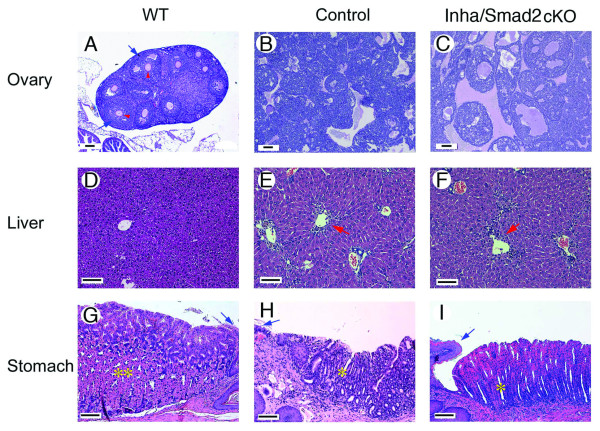
Histological analyses of ovary, liver, and stomach from WT, control, and experimental female mice. (A) Ovarian histology of an 8 wk old WT mouse. The ovary contains follicles at various developmental stages. Arrows indicate granulosa cells and arrowheads denote oocytes surrounded by a magenta-colored zona pellucida. (B and C) Ovarian histology of a 26 wk old Smad2flox/-; Inha-/- mouse (B) and a 23 wk old Smad2flox/-; Inha-/-; Amhr2cre/+mouse (C), respectively. Tumors from both genotypes were bilateral, large, hemorrhagic, and histologically indistinguishable. (D-F) Histology of livers from a 12 wk old WT mouse (D), a 15 wk old Smad2flox/-; Inha-/- mouse (E), and an 8 wk old Smad2flox/-; Inha-/-; Amhr2cre/+mouse (F). Hepatocellular death around the central vein and lymphocyte infiltration are present in the livers of both the Smad2flox/-; Inha-/- control and Smad2flox/-; Inha-/-; Amhr2cre/+mice (arrows). (G-I) Glandular stomachs from a 12 wk old WT mouse (G), a 26 wk old Smad2flox/-; Inha-/- mouse (H), and a 14 wk old Smad2flox/-; Inha-/-; Amhr2cre/+mouse (I). Note the depletion of parietal cells in both the control and experimental mice (single asterisk) in comparison with the WT mouse (the large and eosinophilic cells; double asterisks). The junction ridge between the squamous epithelium of the forestomach and the glandular stomach is indicated by blue arrows. Scale bars = 100 μm.